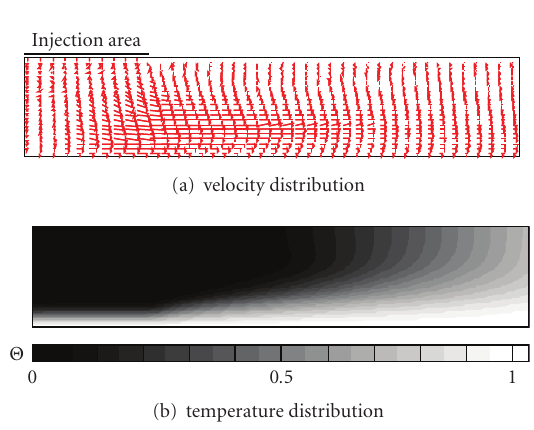
Figure 7: Velocity and temperature distributions in rotating disk at h/D i = 0 . 10, Re = 2000 and Re t = 2000.